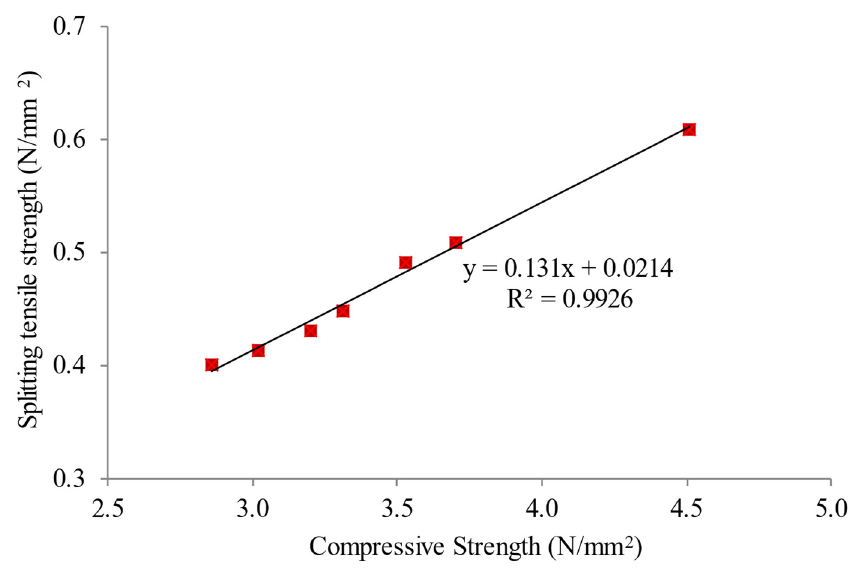
Figure 14. Relationship between compressive and splitting tensile strengths of LFC.